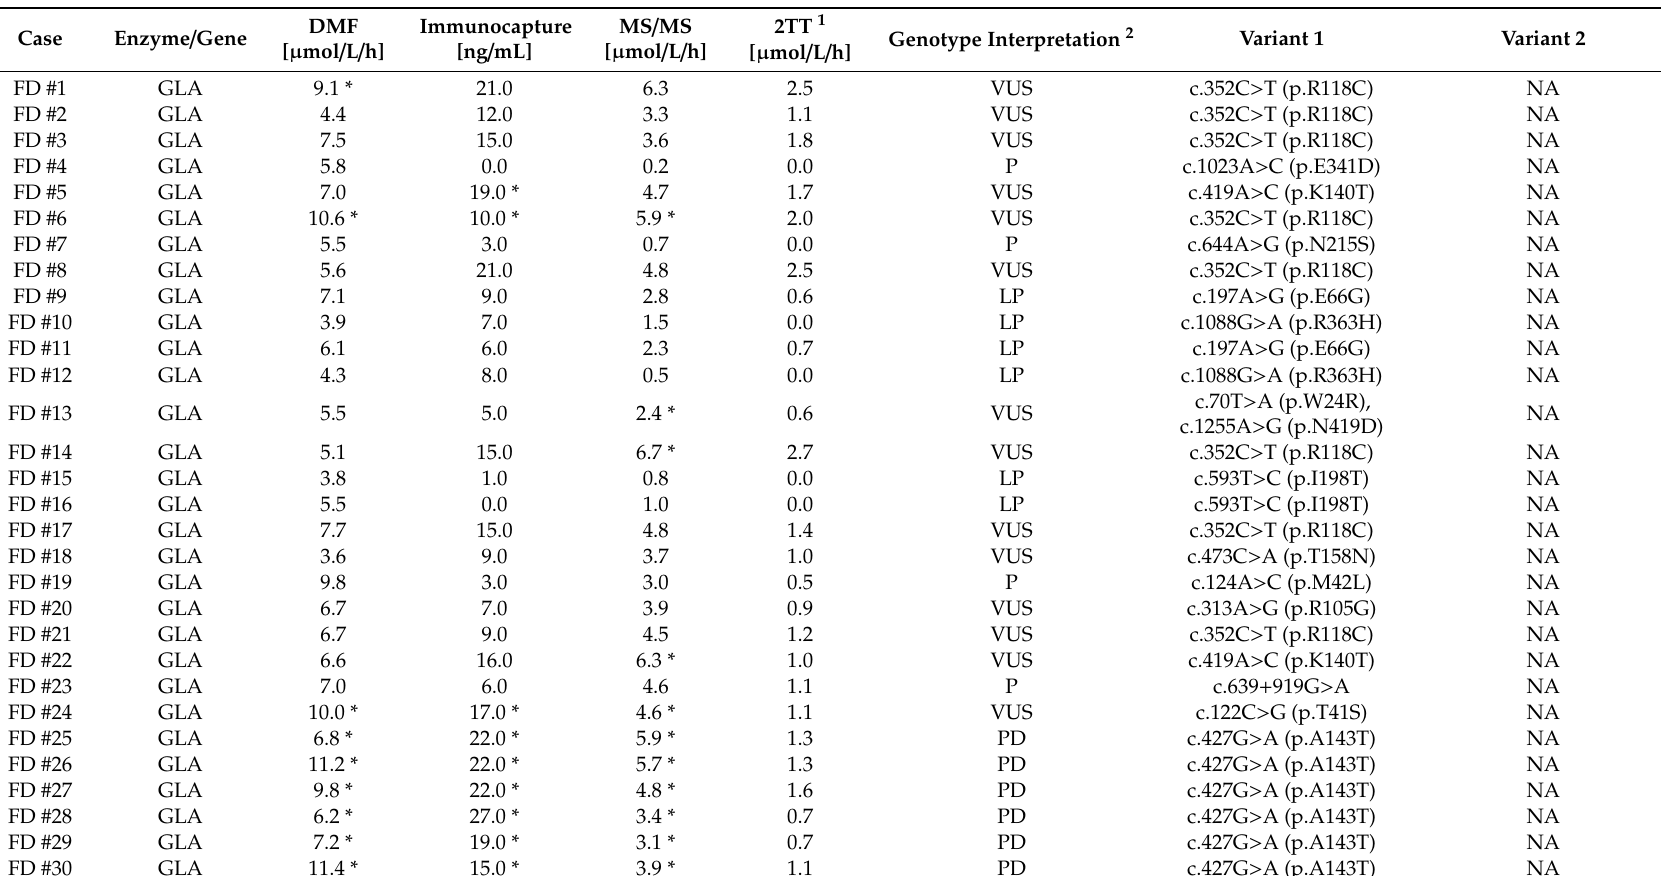
Table 3. Biochemical and molecular genetic results for the true positive cases identified during this study. Cuto ff s for DMF, immunocapture and MS / MS assays are provided in Table 1. Values in bold face are below the relevant cuto ff